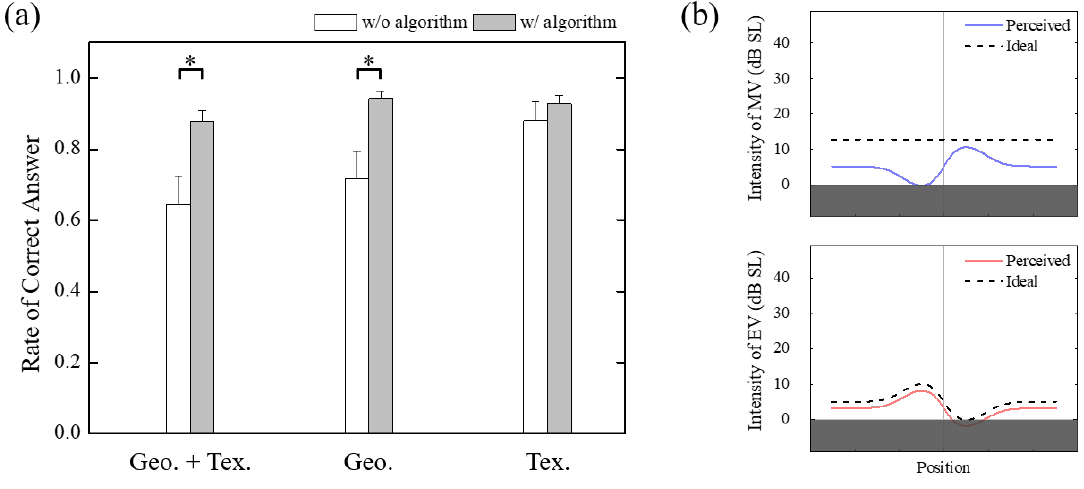
Figure 8. Result of the user test: ( a ) mean rate of correct answers in the geometry and texture discerning test. Error bars represent the standard deviation. Asterisks denote a significant difference between the groups ( p < 0.01); ( b ) example of the expected perceived intensity without the proposed algorithm (a case of combined bump and